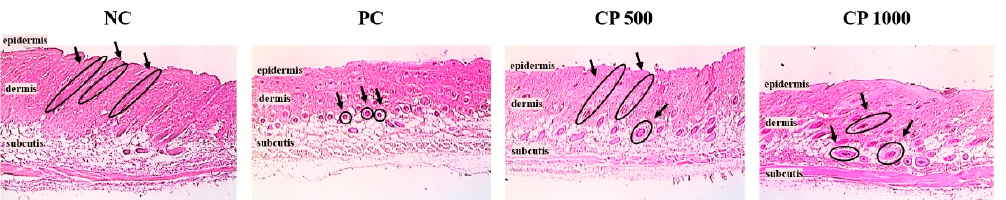
Figure 4. Histological effect of CP treatment. A/T ratio of the dorsal skin of C57BL/6 mice orally treated with CP (500 mg/kg and 1000 mg/kg) for 6 weeks. NC: negative control (distilled water), PC: positive control (finasteride, 1 mg/kg); CP500: collagen peptide, 500 mg/kg; CP1000: collagen peptide, 1000 mg/kg (hematoxylin & eosin stain, 100 × magnification). The arrows represent the hair